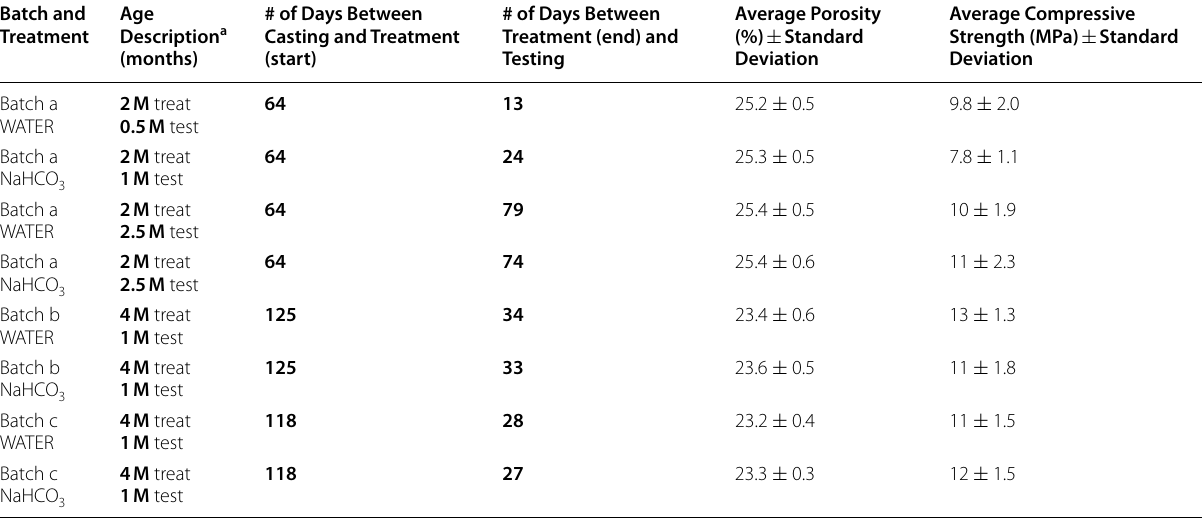
Table 1 Compressive strength and porosity values of groups of specimens, segregated by Batch, treatment and time framings